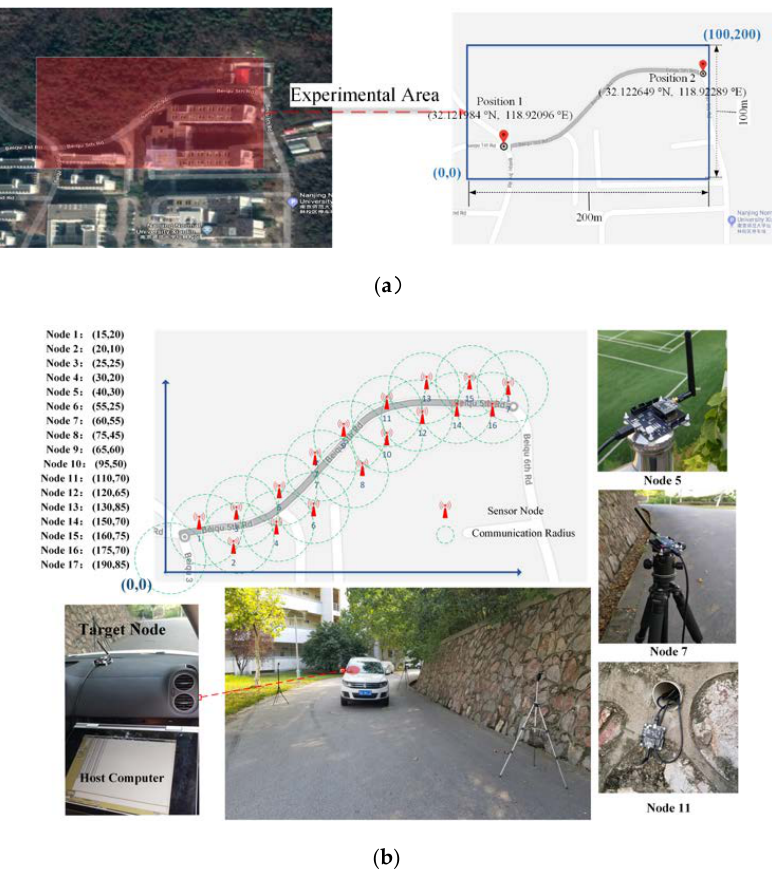
Figure 11. Photograph of experiments: ( a ) Experimental area in GoogleMap; ( b ) deployment of equipment.